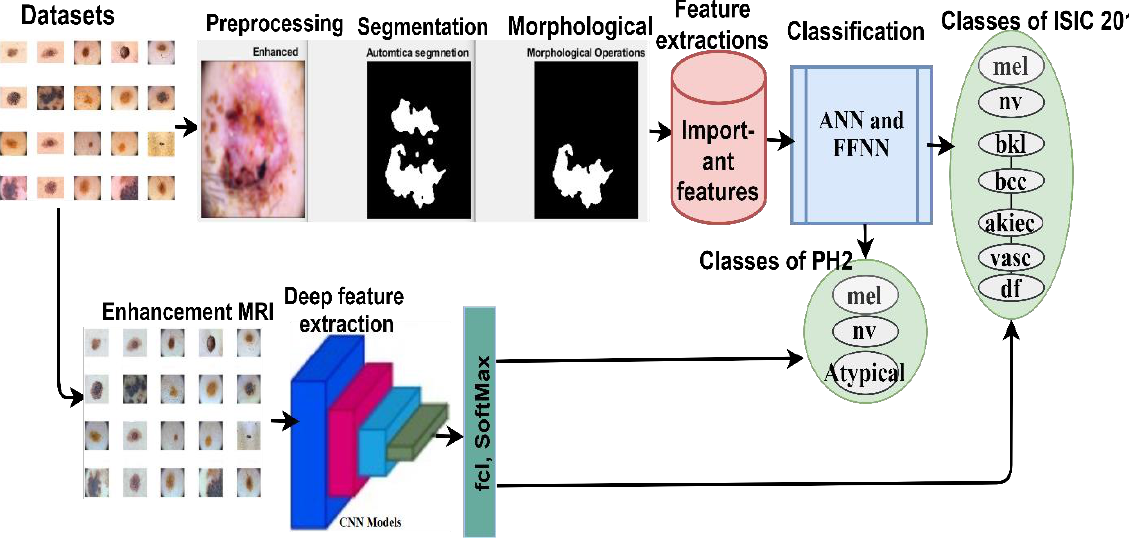
Figure 1. Methodology for classifying the ISIC 2018 and PH2 datasets used in this